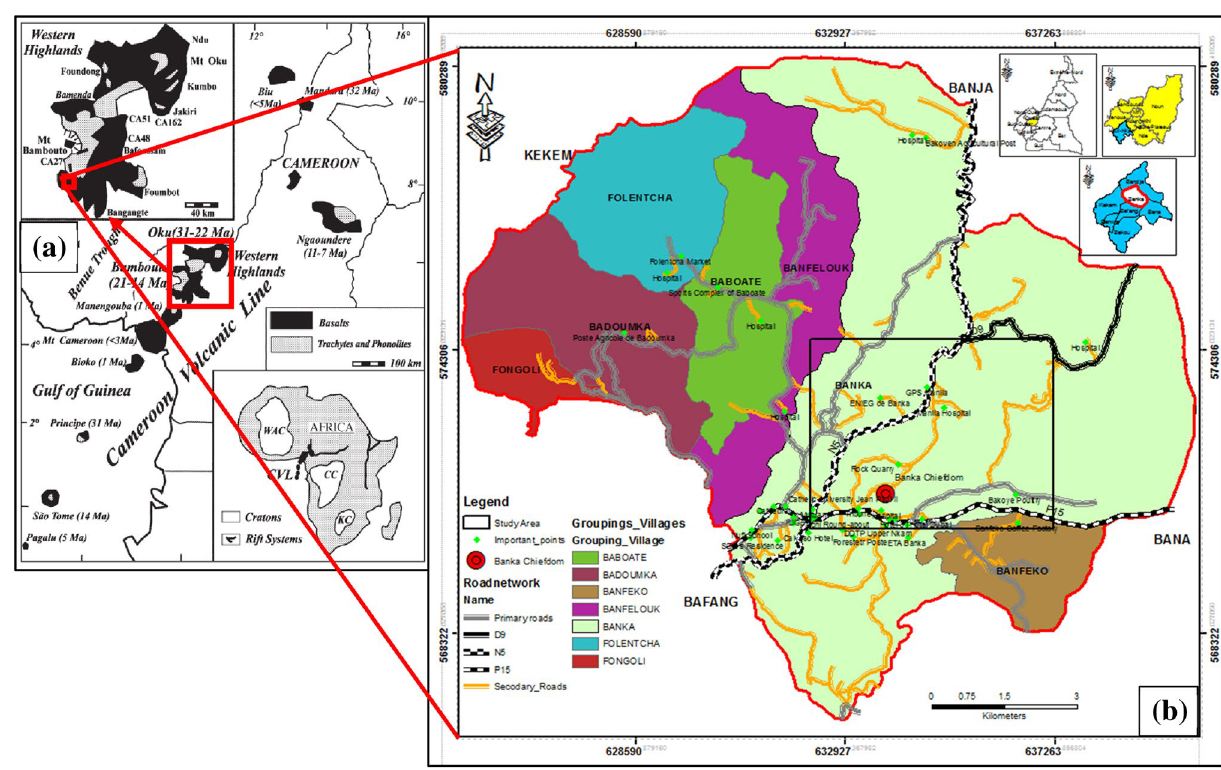
Fig. 1 ( a ) Cameroon Volcanic line showing location of study area on Western highlands (top left inset), modified from [27]; ( b ) is the administrative location map. The black rectangle in the center refers to a 20km 2 zone of interest over whose SRTM DEM is